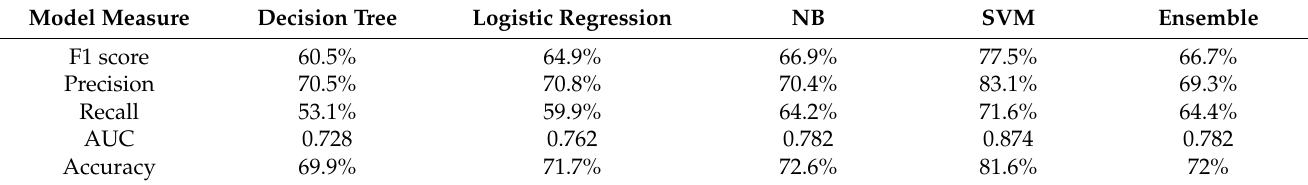
Table 6. All results from all models based on all data.